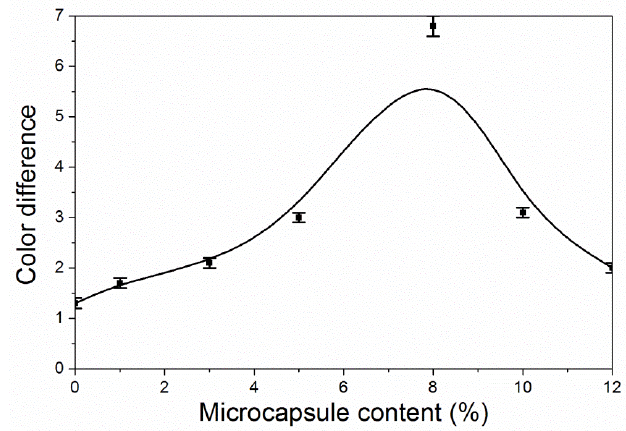
Figure 5. Effect of microcapsule content on color difference of coating.